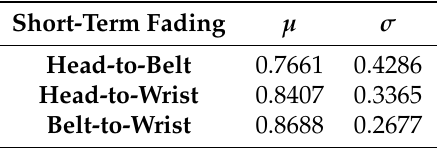
Table 3. Rice parameters of short-term fading for each on-body link.